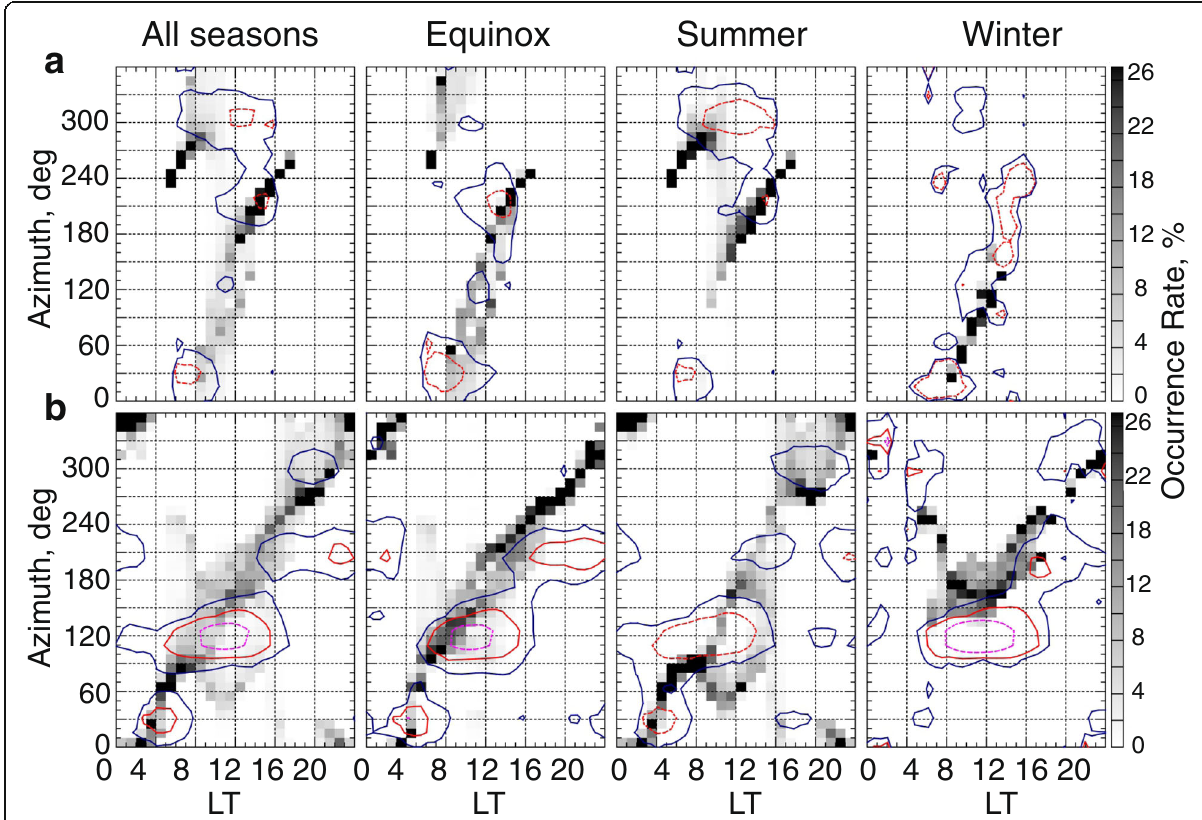
Fig. 29 a – b Modeled rates of anti-wind MSTID direction occurrence versus local time based on the HWM07 neutral wind model (Drob et al. 2008) applied to the center of the HOK FOV. Contours are MSTID occurrence rates according to the HOK observations of ground scatter from the E region. b The same as a but for ground scatter from the F region. Blue, red, and magenta contours are for the rates of 3, 5, and 10%, respectively. Adapted from Fig. 3 of Oinats et al.